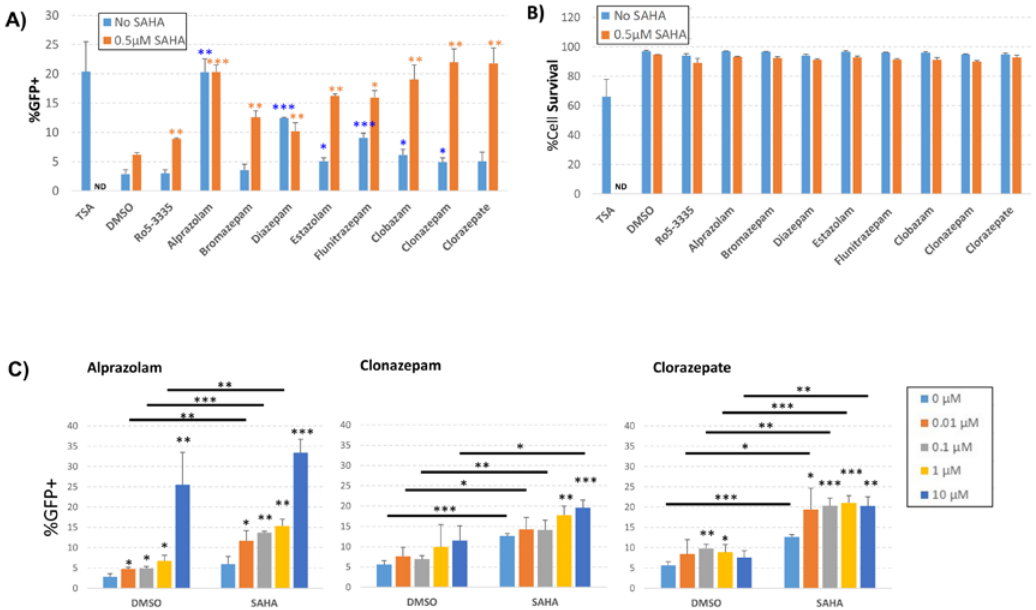
Figure 4. Effect of benzodiazepines (BDZs) on transcription in J-Lat 10.6 cells. J-Lat 10.6 cells were cultured with the indicated BDZs in the presence or absence of 0.5 µM SAHA. 48 h after treatment, cells were measured for the percentage of GFP positive cells and were stained for viability as determined by flow cytometry. ( A ) The percentage of GFP positive live cells after treatment with 10 µM of different BDZs. ( B ) 48 h after treatment, cells were stained for live/dead determination and the percentage of live cells was measured by flow cytometry. ( C ) Dose response graph for cells treated with selected BDZs alone or in combination with 0.5 µM SAHA. ND = not determined * P ≤ 0.05, ** P ≤ 0.01, *** P ≤ 0.001. Statistical significance of BDZs alone is compared to DMSO (blue asterisks). When combined with SAHA, statistical significance is compared to SAHA (orange asterisks).